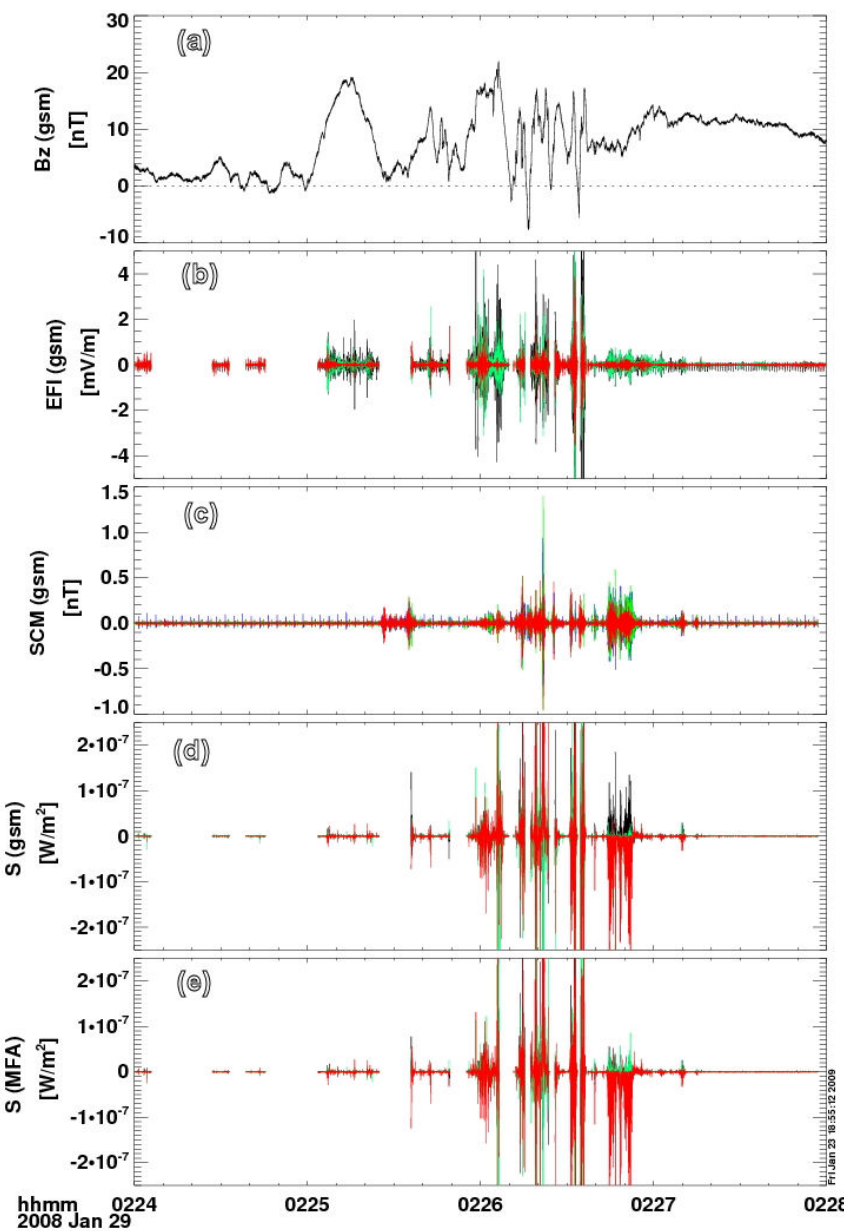
Fig. 5. Panels (a) B z component (128S/s) in GSM coordinates, (b) EFI and (c) SCM waveforms (128S/s) filtered below 10Hz in GSM coordinates (x:black, y:green, z:red), Poynting vector in GSM (d) and MFA coordinates (e) .